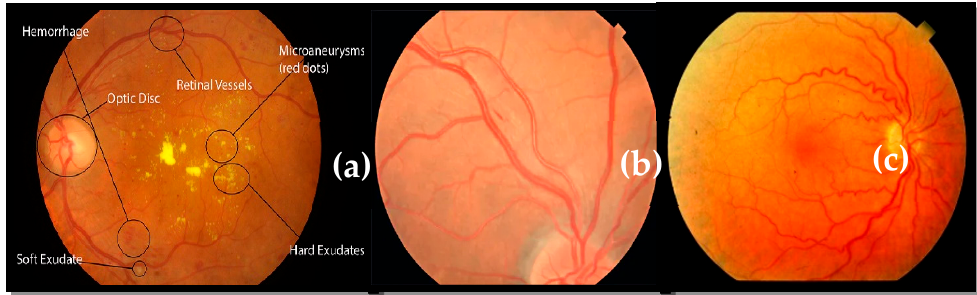
Figure 1. An instance of main HR symptoms are: ( a ) optic disk, cotton wool patches, hemorrhages and microaneurysms, ( b ) A/V ratio and ( c ) tortuosity.